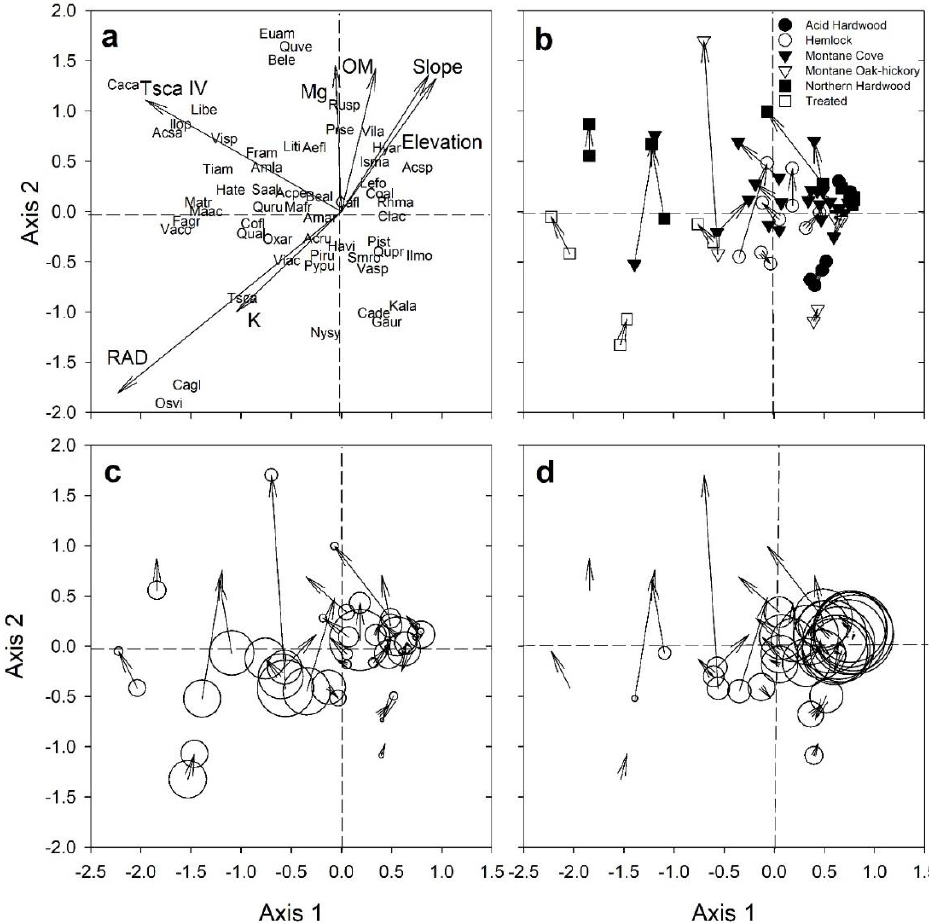
Figure 4. NMDS ordination of sapling species relative density: ( a ) Biplot of sapling strata species in 2017; significant (α = 0.1) environmental variables Mg (ppm soil magnesium), OM (percent soil organic matter), Slope (percent slope), Elevation, K (ppm soil potassium), RAD (total potential incident radiation), and Tsca IV (pre-HWA overstory importance value of T. canadensis ) are shown as vectors; ( b ) Successional vectors indicating change in composition from 2003 (pre-HWA) to 2017 (post-HWA) by ecogroup; ( c ) Successional vectors showing compositional change and bubble plot showing change in overstory T. canadensis IV between 2003 and 2017; and ( d ) Successional vectors showing compositional change and bubble plot showing relative density of R. maximum in 2003. Species abbreviations: Acpe